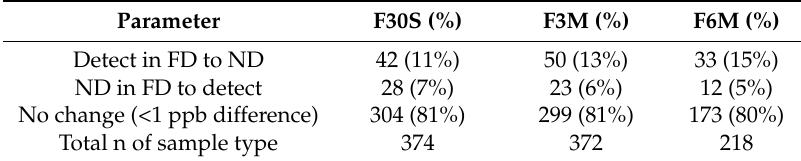
Flushing effectiveness based on reaching non-detectable water lead levels (WLLs) (ND: <1